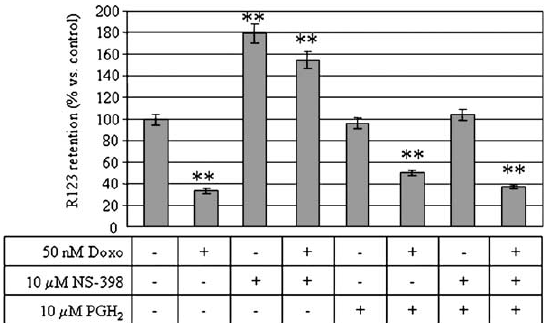
Fig. 3. R123 assay. rMCF7 cells were treated for 2 days without (control) or with 50 nM Doxo, 10 µM NS-398, 10 µM PGH 2 alone or in combination. Cells were then incubated with 4 µM R123, washed, and lysed. Sample fluorescence was measured and normalized by the protein content. Data from three individual experiments evalu- ated independently with three replicates are expressed as the mean ± SE percent R123 retention as compared to untreated control cells. ** p < 0 . 01 vs. untreated control rMCF7